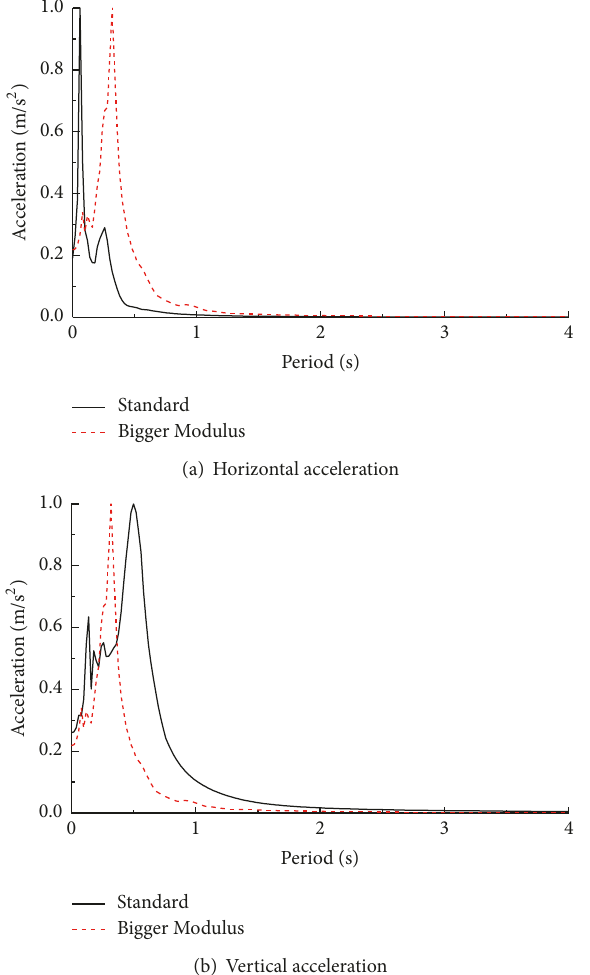
Figure 31: Spectrum curves of horizontal and vertical acceleration at node 103 under standard case and Bigger Modulus case.